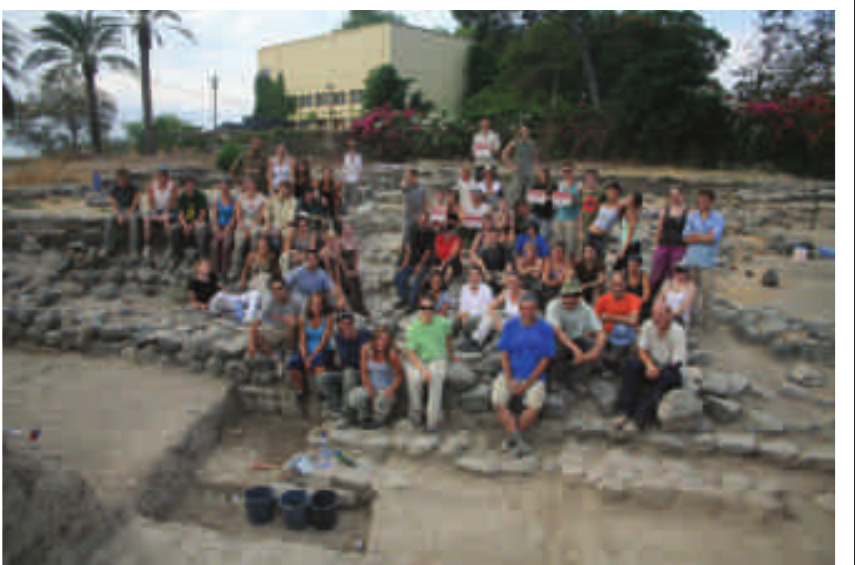
Figure 8 The 2009 team, on the final day of excavations